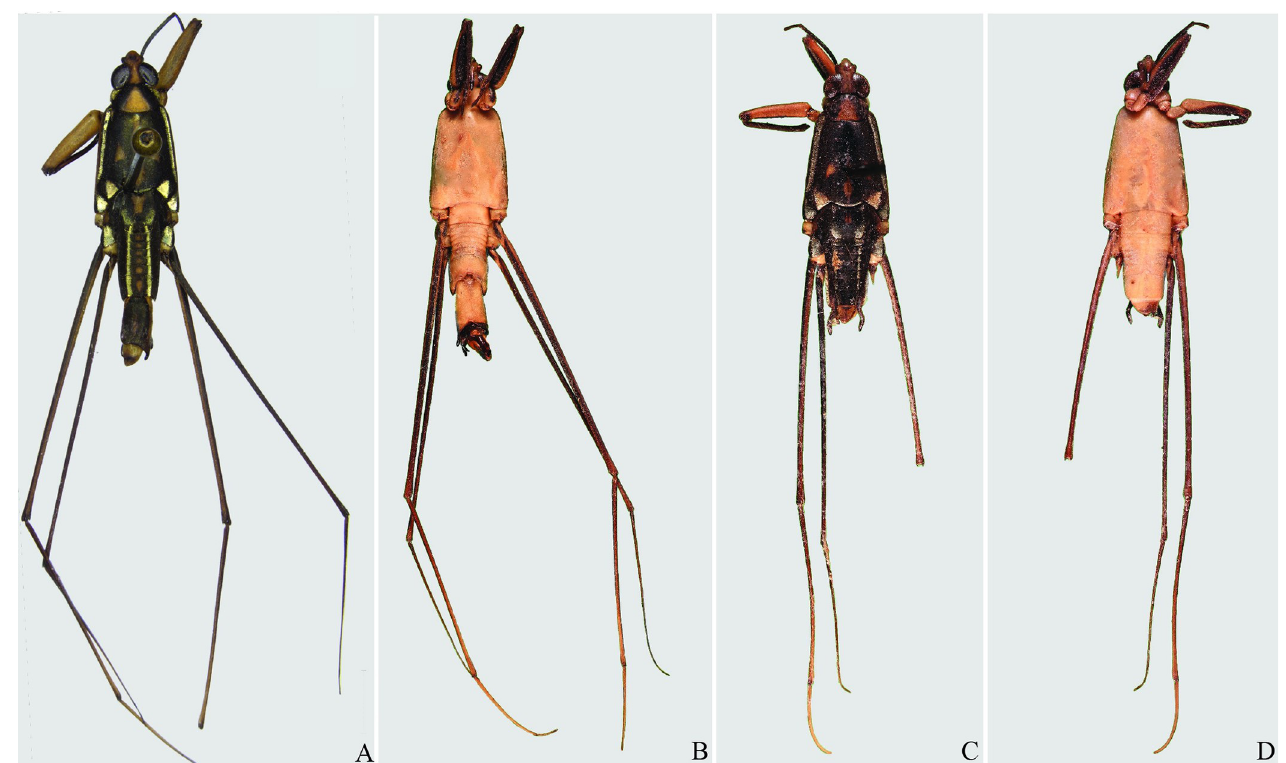
Fig 34. Potamobates williamsi . (A) Male, dorsal view; (B) male, ventral view; (C) female, dorsal view; (D) female, ventral view.